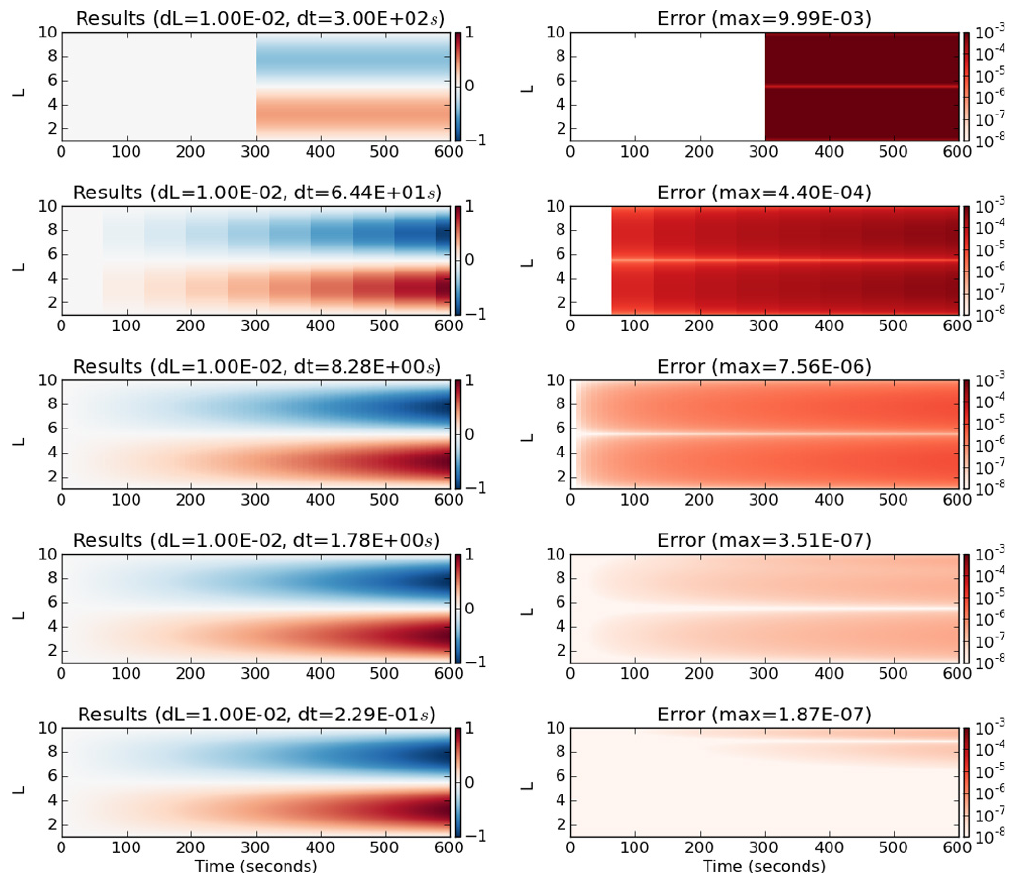
Fig. 9. Similar to Fig. 4, but showing results when the second, non-periodic manufactured solution is used (Eq. 9).